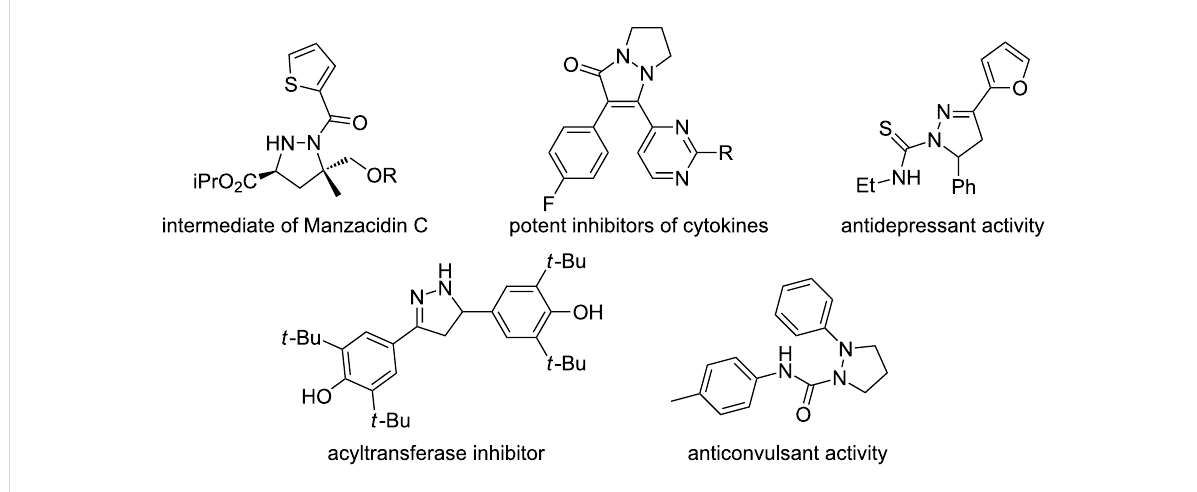
Figure 1: Important heterocycles containing pyrazolidine or pyrazoline structures.